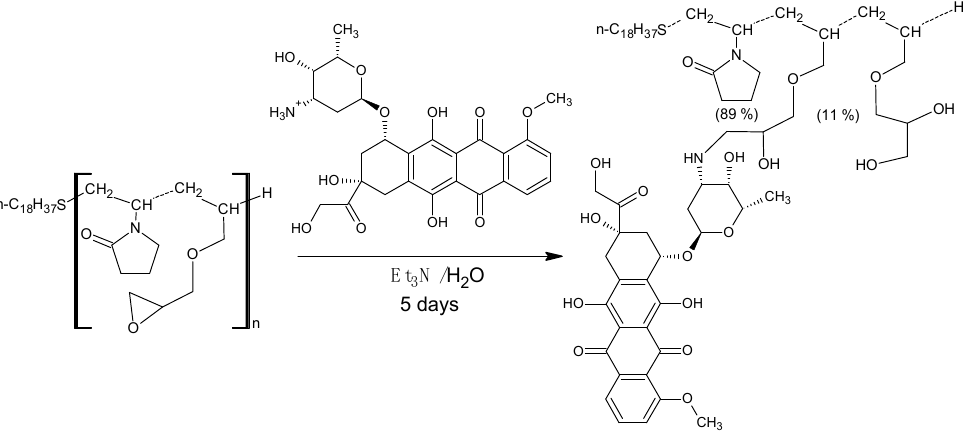
Scheme 3. Covalent immobilization of doxorubicin on the amphiphilic copolymer of N-vinyl-2-pyr- rolidone and allyl glycidyl ether. rolidone and allyl glycidyl ether.